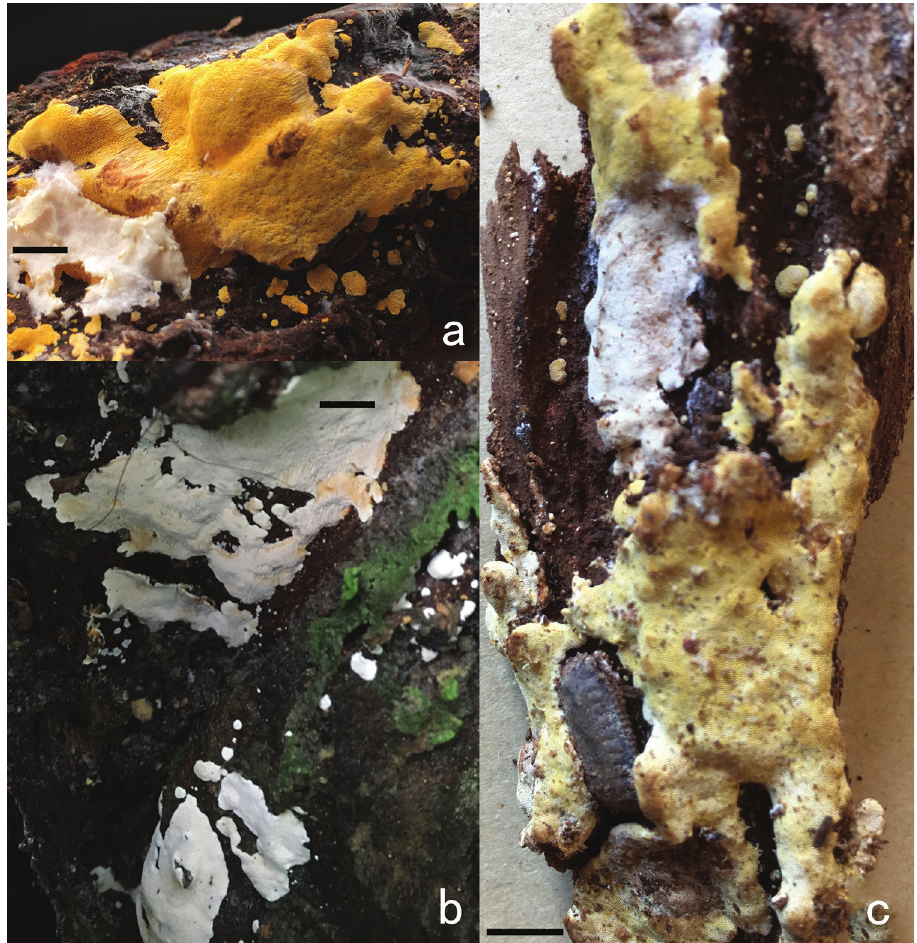
Figure 6. Basidiocarps of Perenniporia corticola a Dai 18641 b Dai 18633 c Dai 17778. Scale bars: 1 cm. Photos by Yu-Cheng